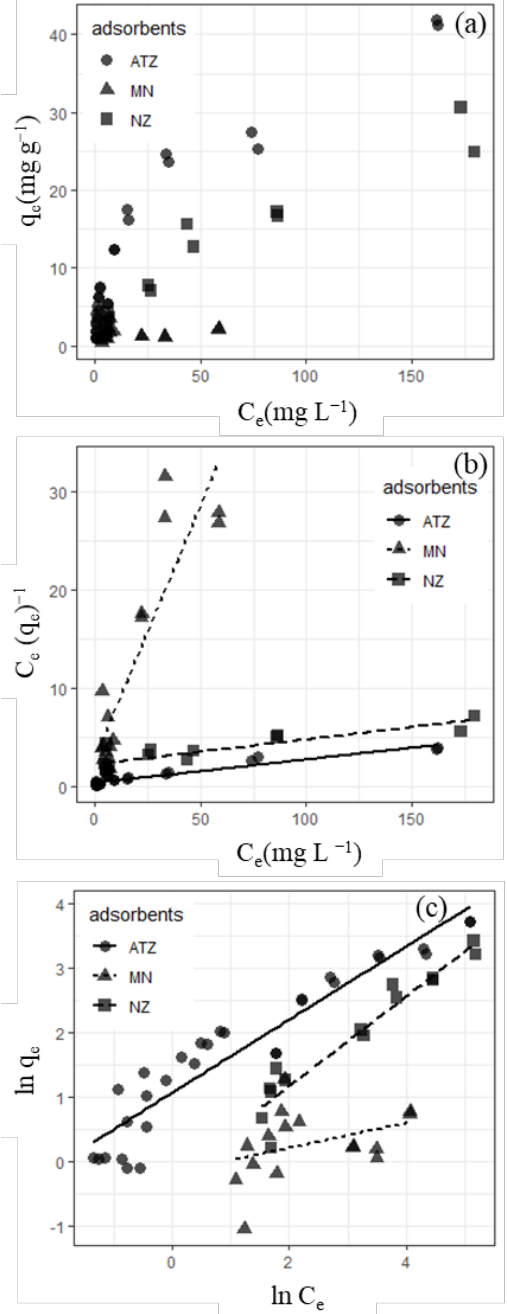
Figure 1. ( a ) Adsorption isotherm; ( b ) Langmuir isotherm; and ( c ) Freundlich isotherm of potassium (K) in potassium chloride (KCl) solutions on natural zeolite (zeolite), ammonium acetate − treated natural zeolite (Treated zeolite), and manganese nodule (manganese nodule) at pH 4.57. The q m values, related to the maximum K sorption capacity, derived from the Lang- When the natural zeolite and the ammonium acetate-treated zeolite are compared, muir isotherm model show that the ammonium acetate-treated zeolite has the greatest K the K sorption capacities indicated by the q m values and K F values were greater for the adsorption capacity among the adsorbents studied, followed by the natural zeolite and ammonium acetate-treated zeolite (Table 1). This agrees with previous studies where the ammonium acetate-treated zeolite showed an improved Na sorption capacity over the untreated natural zeolite [10]. The greater K sorption capacity of the ammonium acetate- treated zeolite than the natural zeolite is also supported by the higher specific surface area and pore volume. The specific surface areas of the natural zeolite and the ammonium acetate-treated zeolite were 29.2 and 33.0 m 2 g − 1 , respectively, and the pore volumes